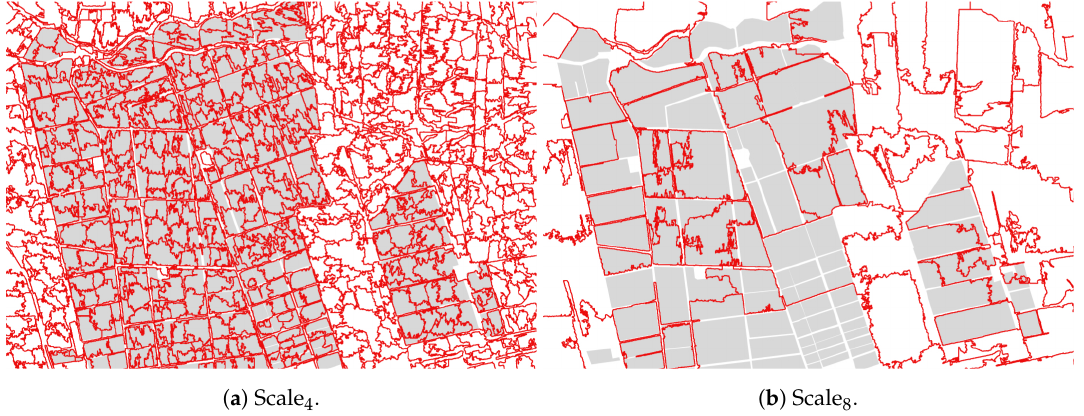
Figure 4. Superpixels for different scales are overlaid onto the ground truth of the study area with red color. From the 10 segmentation scales for each date generated and consensus, the edge maps shown in Figure 5a–c were